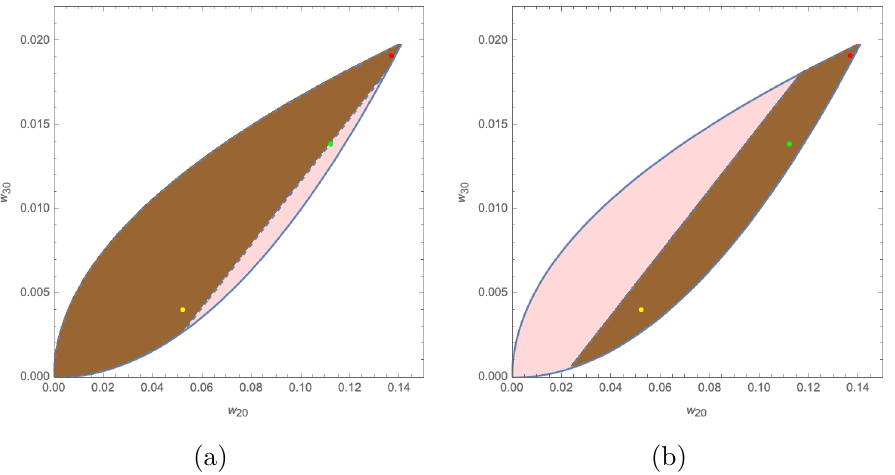
Figure 11. Using the full D 3 ≥ 0 on figure 10(a). (a) When all w pq except w 30 , w 20 set to maximum with w Brown indicates the restricted allowed